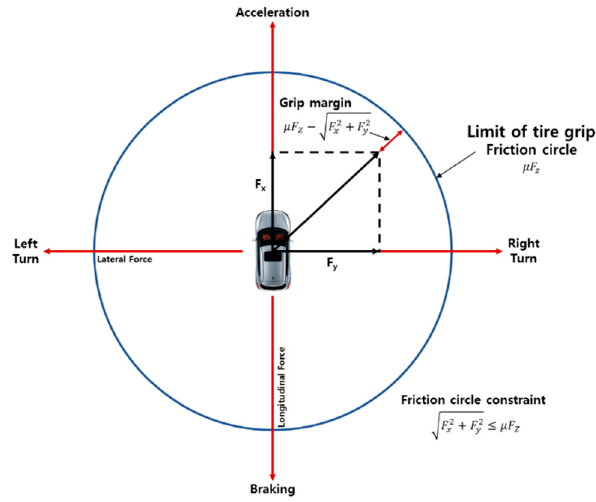
Figure 1. Concept of friction circle.